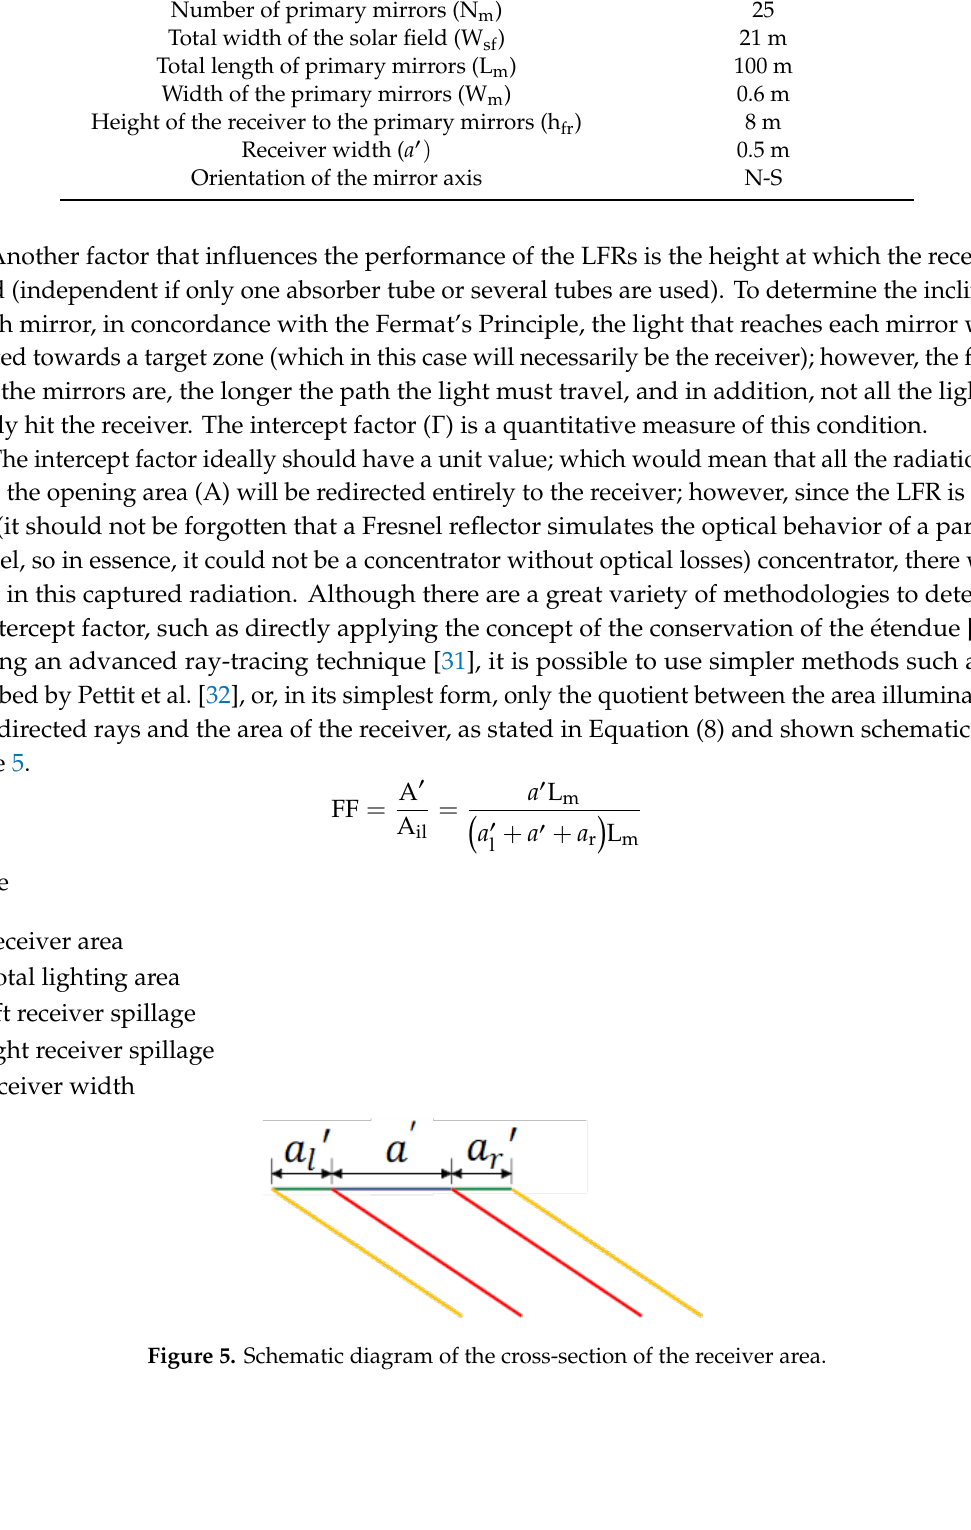
Table 1. Geometric data of a FRESDEMO similar field.